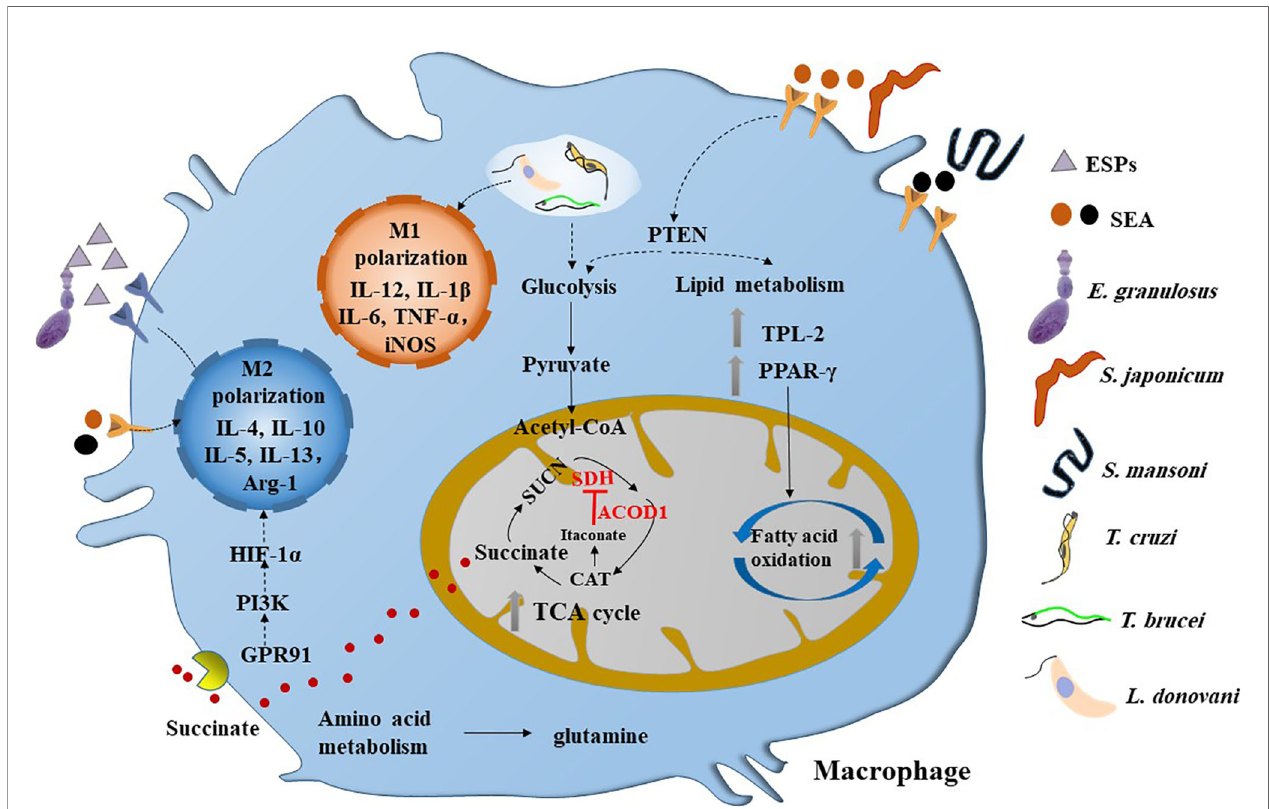
FIGURE 1 | Parasitic infections induce the metabolic reprogramming in macrophages. M1 type macrophages can be activated by the infection of intracellular parasites such as T. cruzi , T brucei and L. donovani , which are characterized by glycolysis. However, helminths infection can induce the M2 polarization of macrophage in the chronic stage, which are dominated by fatty acid oxidation and broken of TCA cycle. The SEA of Schistosoma sp. can inactivate PTEN and its downstream pathway, thereby promoting glycolysis and fatty acid oxidation and inducing a mixed but type 2 biased anti-in fl ammatory response in macrophage. Interestingly, the ESPs of larval E. granulosus can activate the expression of ACOD1, which can encodes the enzyme that catalyzes the cis-aconitate to produce itaconate in the TCA cycle. It is reported that itaconate can inhibit the activity of SDH, thereby leading to the accumulation of succinate. Moreover, the succinate can activate GPR91 to induce the M2 polarization of macrophage through PI3K/HIF-1 a pathway. ESPs, excretory/secretory products; SDH, succinodehydrogenase; GPR91, G-protein coupled receptor 91; SEA, soluble egg antigens; CAT, cis-aconitate; HIF-1 a , hypoxia-inducible factor 1 a ; PTEN, phosphatase and tensin homolog; TPL-2, tumor progression locus 2; PPAR- g , peroxisome proliferator activated receptor- g